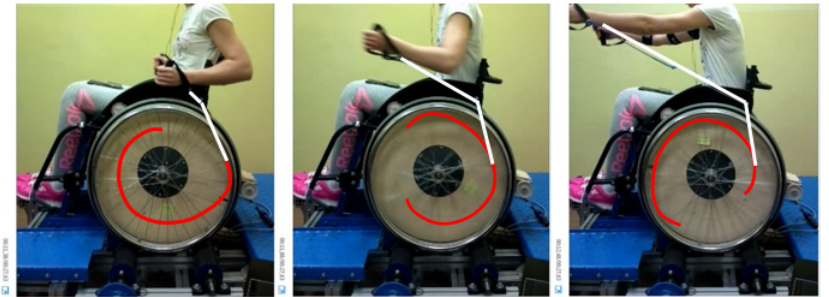
Figure 5. Three stages of drive movement during test-bed EMG tests of a wheelchair prototype with Wheelchair Cam-thread Drive (WCD) (in the figure, the cam shape has been marked with a red line, and the course of the drive cable has been marked with a white line).